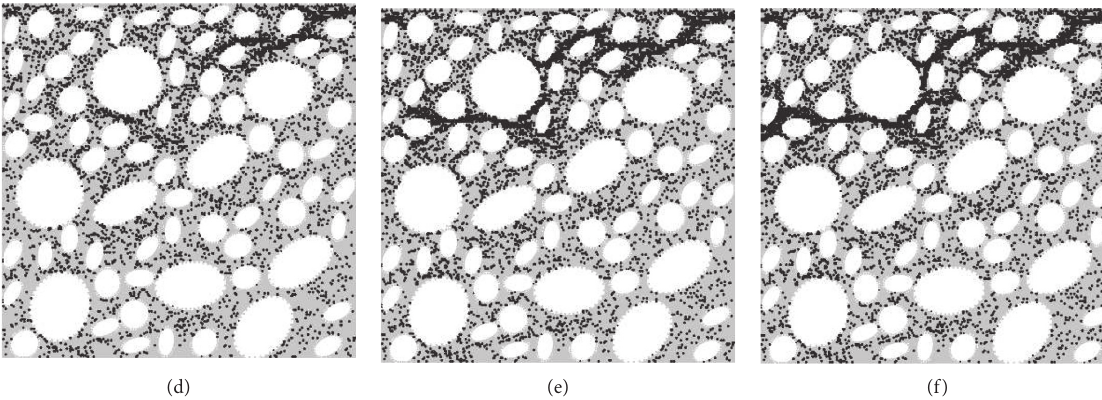
Figure 7: Mesoscale damage evolution process of the specimen under uniaxial compression. White and light-gray colors represent aggregates and mortar matrix, respectively, and dark-gray and black colors denote shear failure and tension failure, respectively.